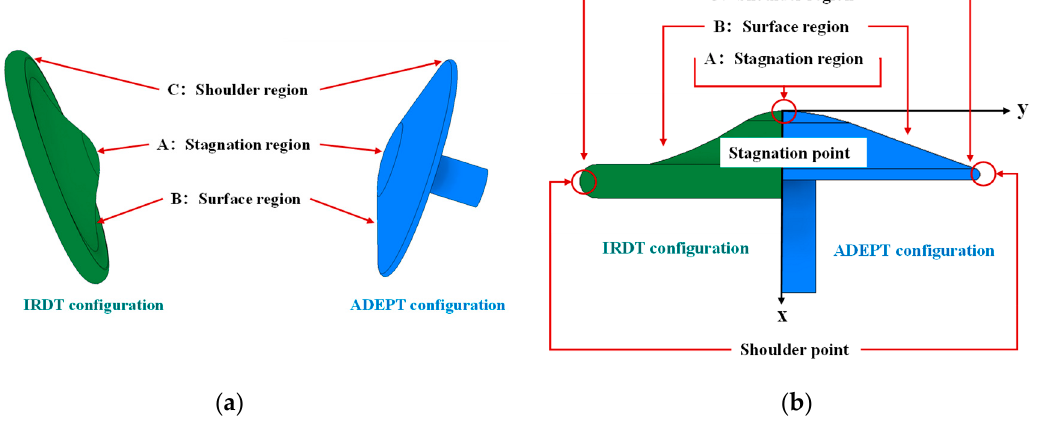
Figure 1. Configurations of IRDT and ADEPT ( a ) 3D models’ comparison; ( b ) division of surface regions.